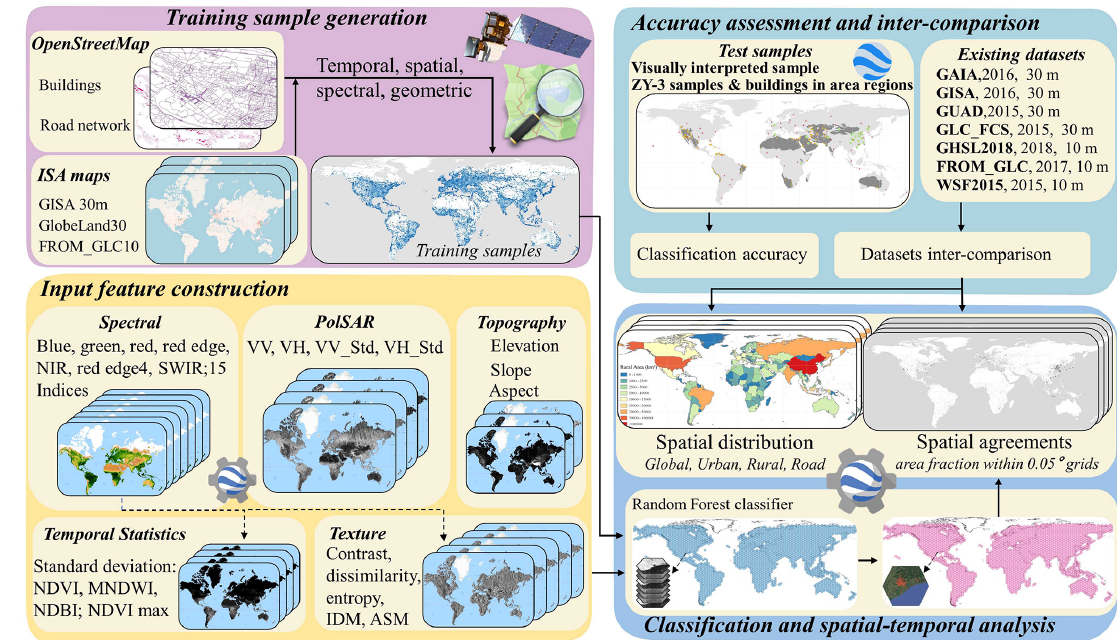
Figure 1. The flowchart for GISA-10m